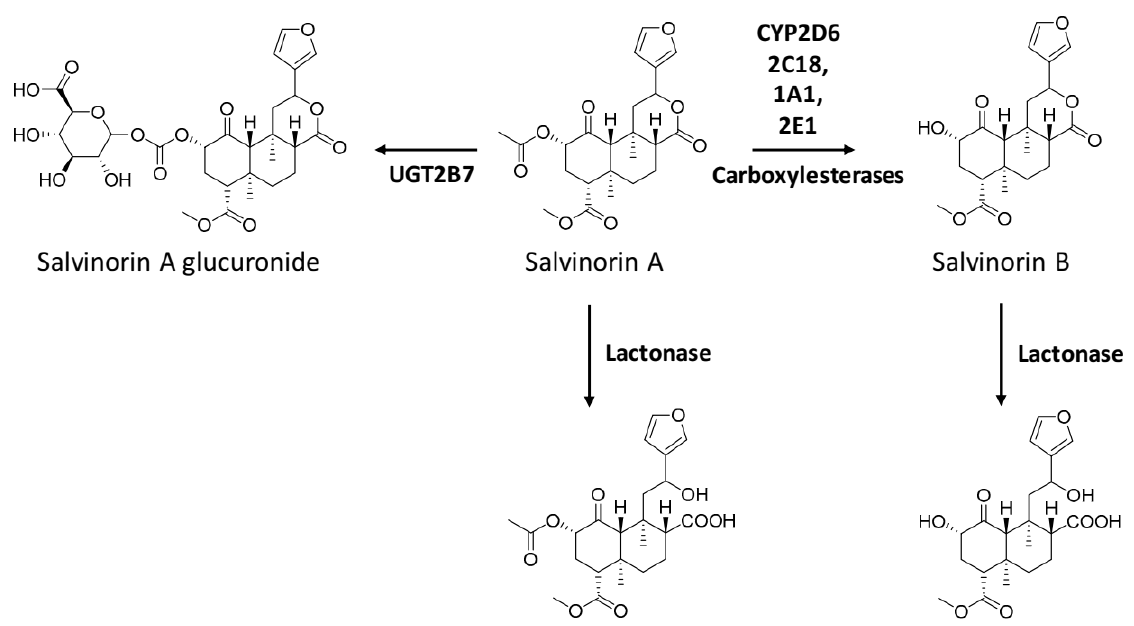
Figure 3. Metabolism of salvinorin